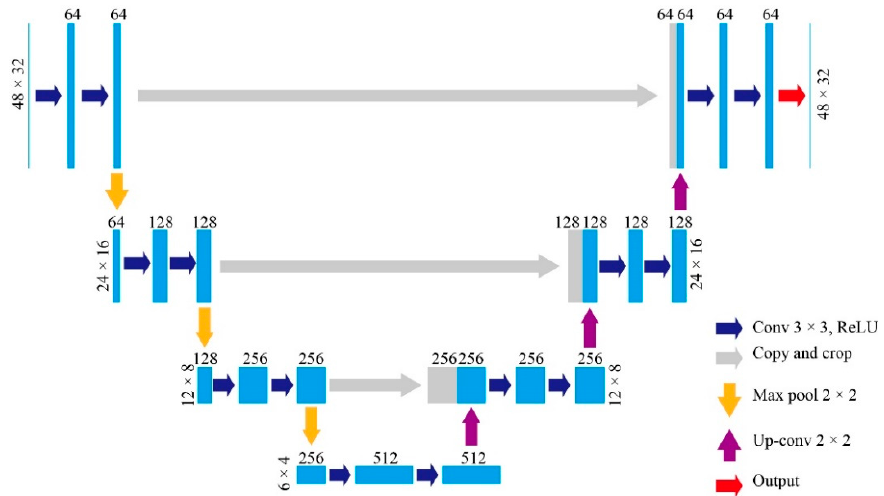
Figure 3. The U-net architecture for fault detection.